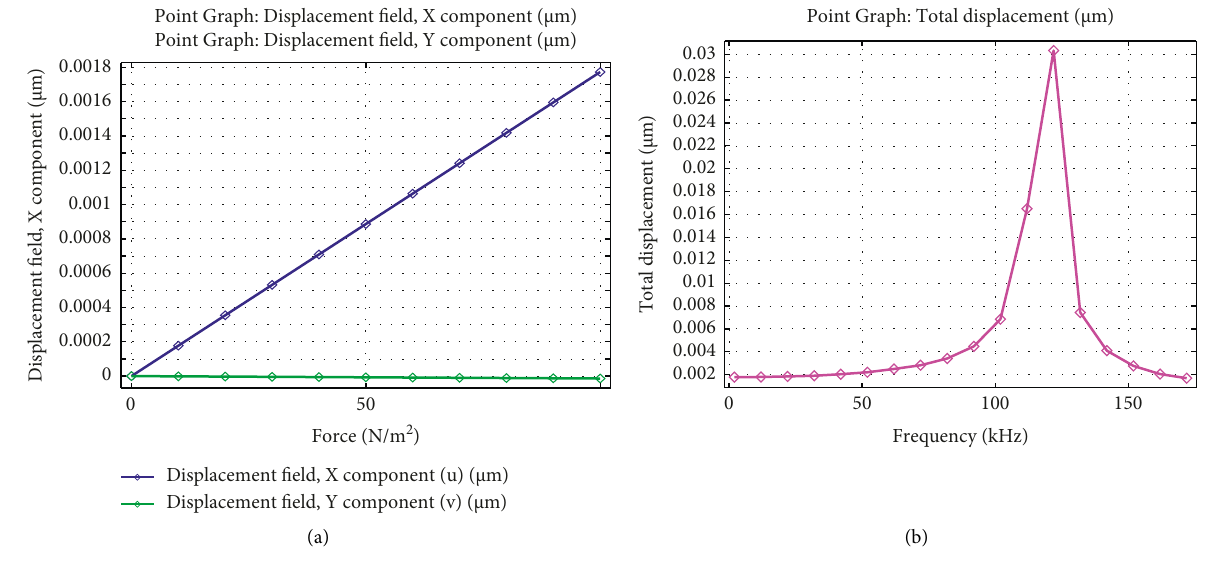
Figure 9: (a) Displacement characteristics; (b) natural frequency for the proposed sensor 3.